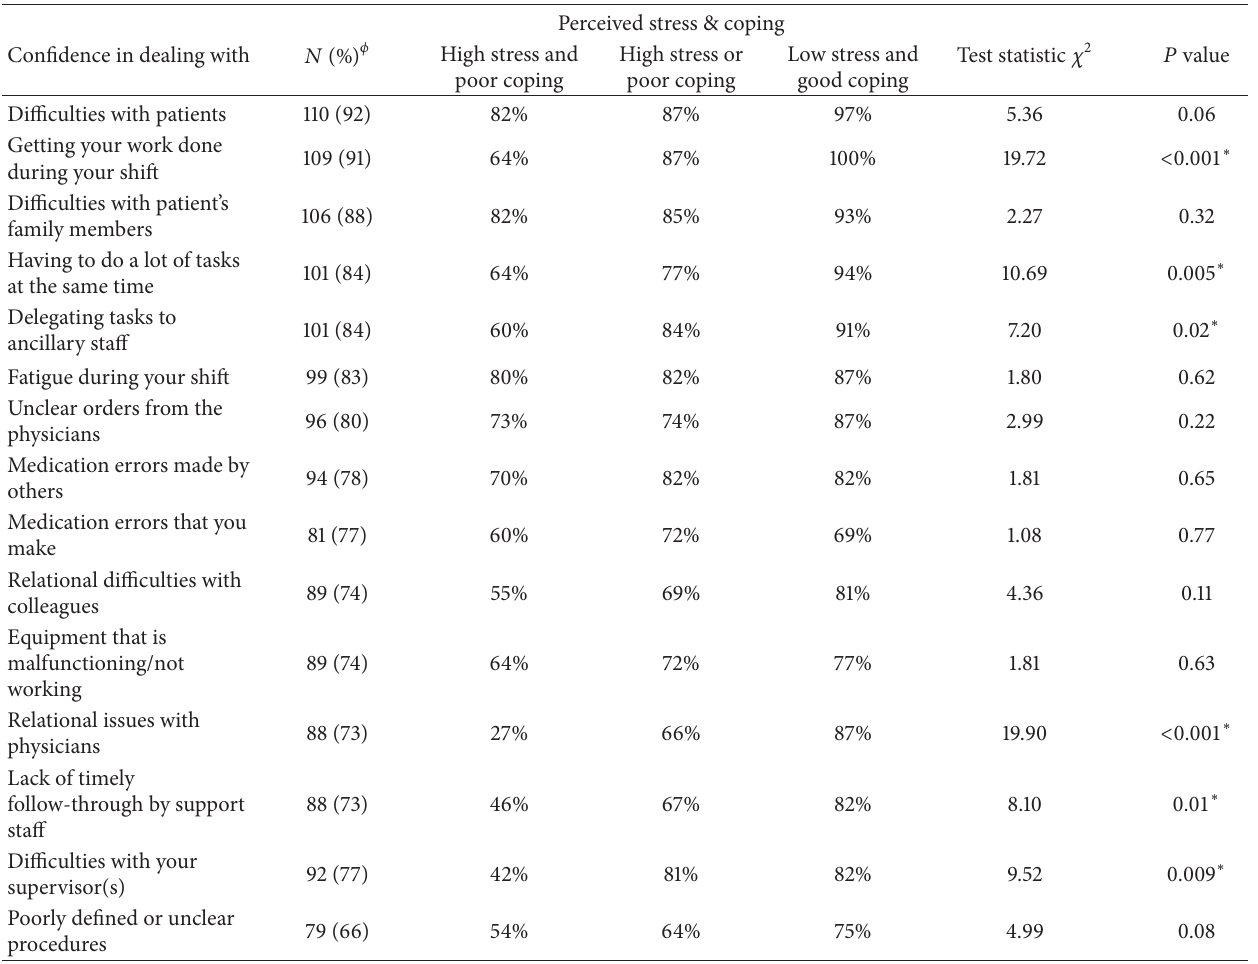
Table 7: Situation specific self-efficacy at work compared by level of stress and adequacy of